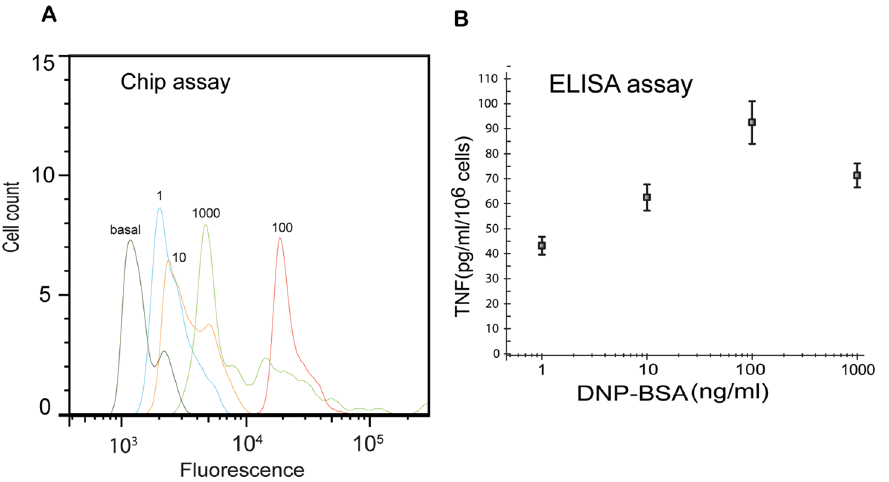
Figure 6. Analysis of TNF a production. Cytokine production by RBL-2H3 cells was measured by m flow cytometry and ELISA after cells were stimulated with doses of DNP-BSA ranging from 1 to 1000 ng/ml. Cells were challenged in the presence of Brefeldin A to block cytokine transport processes. A) m flow cytometric measurements of TNF a production. B) ELISA measurements of TNF a production.